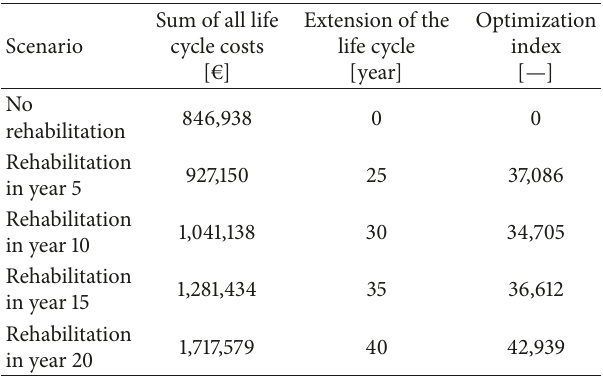
Table 8: Calculation of optimization